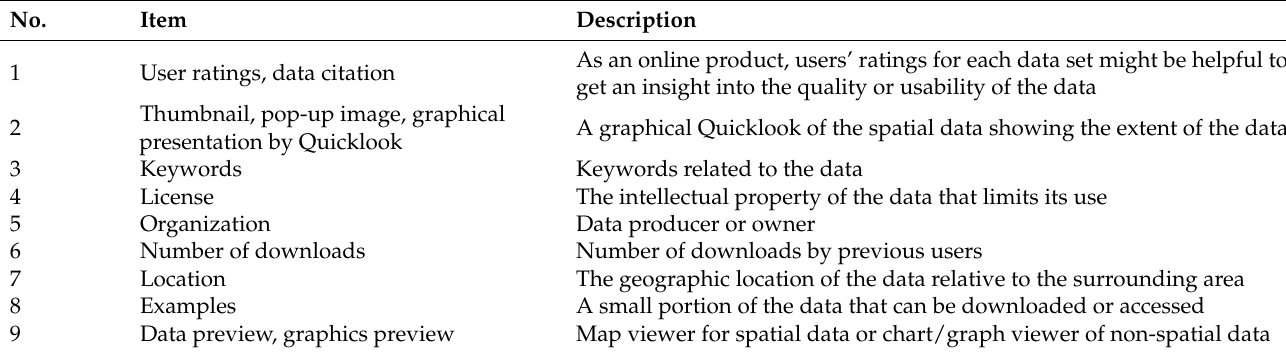
Table 13. Additional information concerning the search results